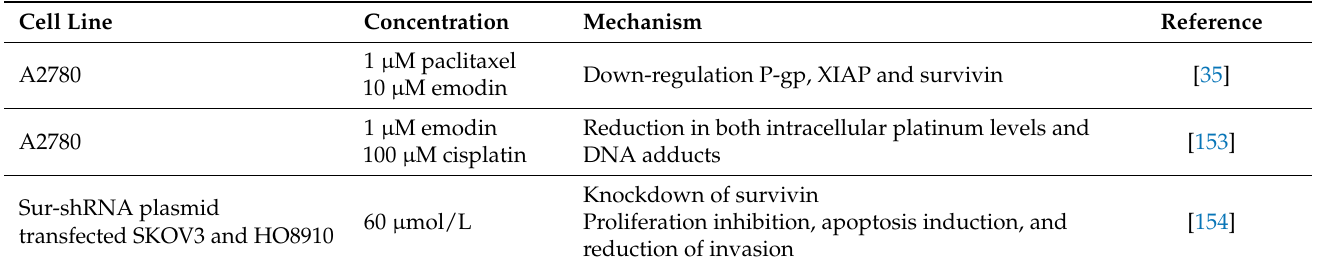
Table 8. Summary of in vitro biochemical effects of emodin in ovarian cancer cell lines. Cell